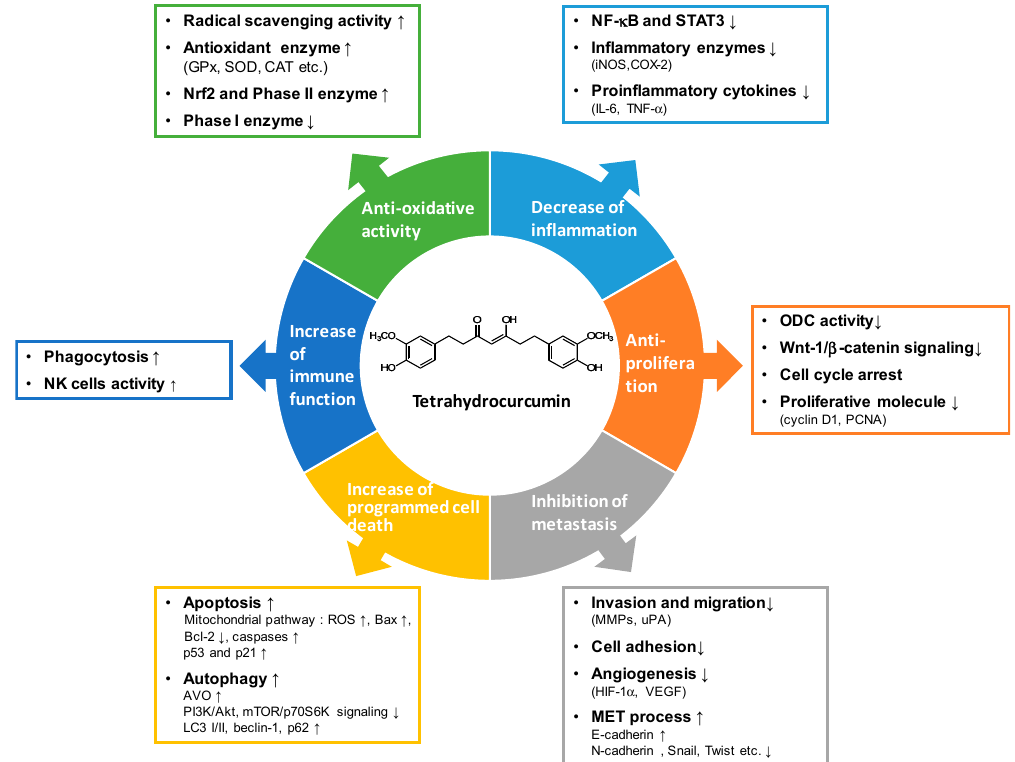
Figure 3. The potential mechanism of actions and molecular targets for tetrahydrocurcumin in prevention and treatment of